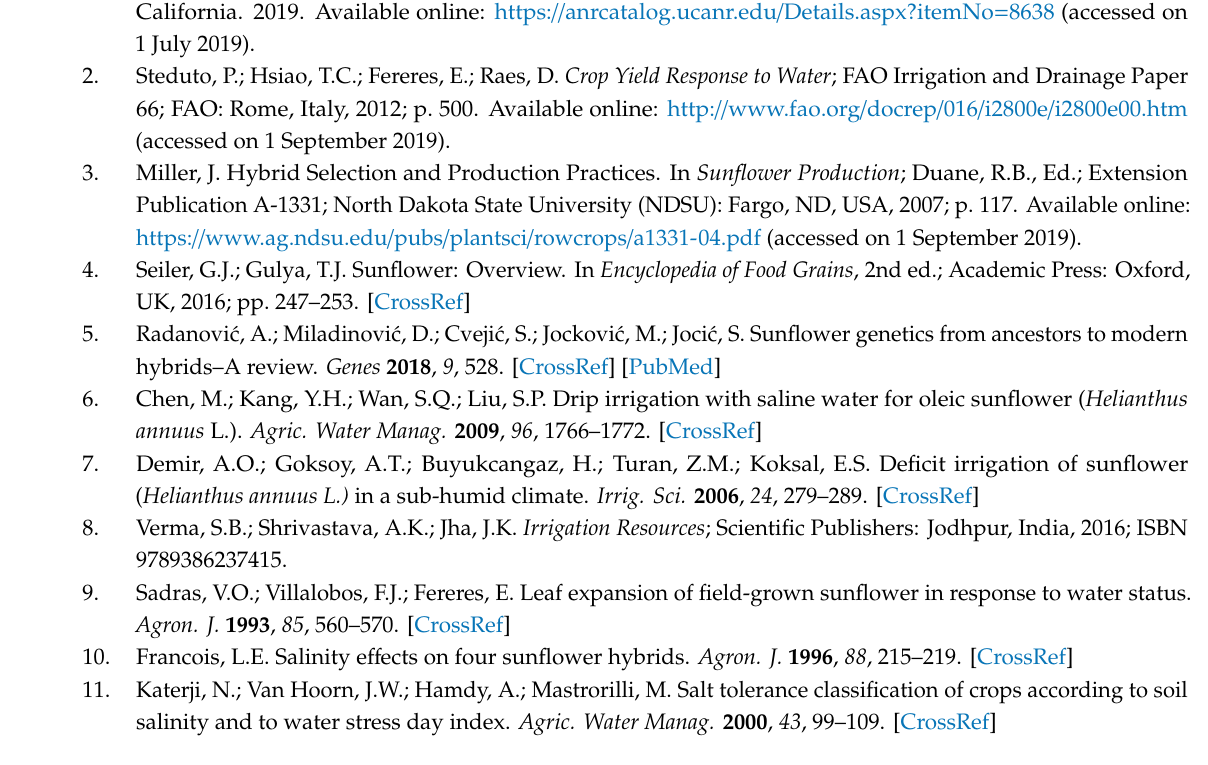
Table S1: Chloride concentrations (ppm) and salinity (dS · m − 1 ) for the collected groundwater samples in 9th April and 28th June for the five locations at observation wells while they recorded 98 ppm and 1.13 dS · m − 1 for the irrigation water, Table S2: Salinity (dS · m − 1 ) for the collected soil samples in 9th April and 28th June for the five locations at observation